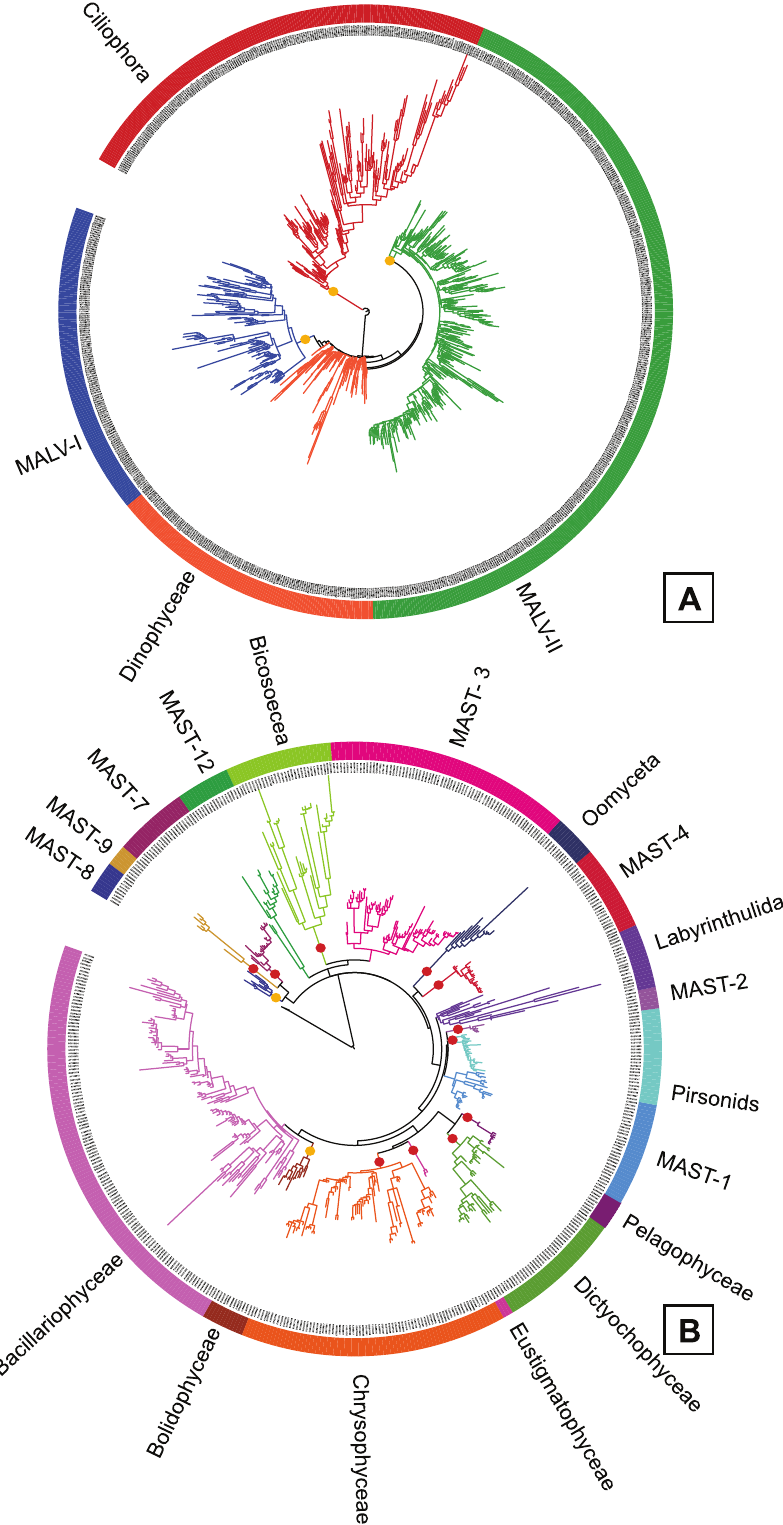
Figure 2. Maximum Likelihood phylogenetic trees for eukaryotic supergroups. Trees include several taxonomic groups within Alveolata (A), Stramenopiles (B), and are done with sequences representative of each OTU obtained clustering at 0.05 distance (A) and 0.01 distance (B). The number of sequences (about 550 bp in length) per tree is 798 and 523 respectively. Red dots represent bootstrap values above 75 and orange dots values above 50.